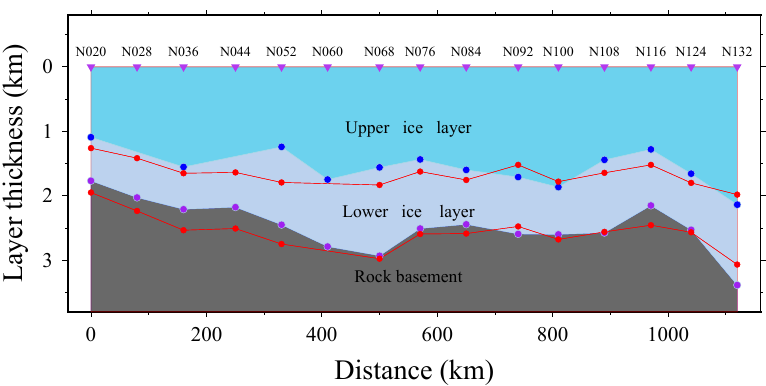
Figure 9. Comparisons of the two-layer ice sheet structure obtained from our study and Wittlinger and Farra’s (2012). The red dots shown at a shallower depth denote the interface between the upper and the lower ice sheet obtained in this study. The interface is generally consistent with that determined with the PRF method and a grid search stacking technique (as shown the blue dots) (Wittlinger and Farra, 2012, Table 1). The red dots shown at a deeper depth represent the overall ice thickness derived from model B, which is also consistent with the radar ice thickness (as the purple dots show) adopted by Wittlinger and Farra